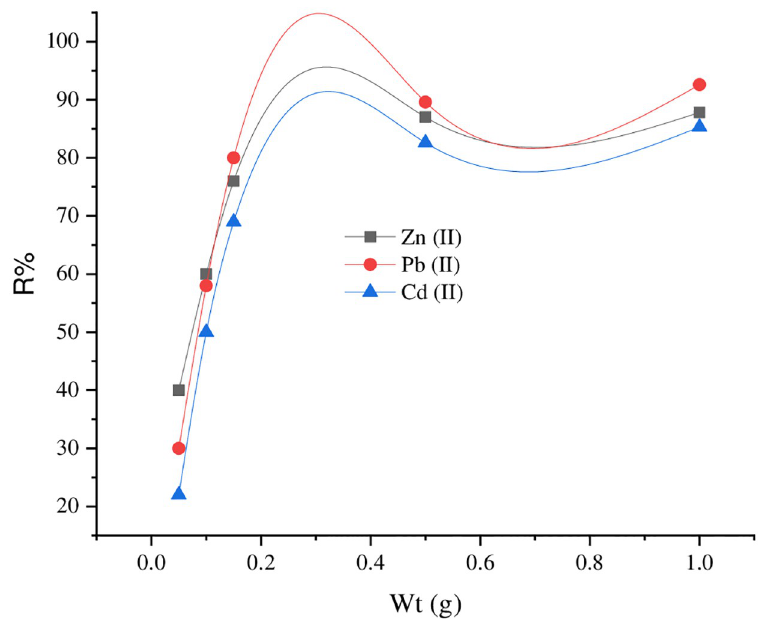
Fig 10. The SnCaAl 2 O 3 nanoparticles dose effect on the adsorptions of Zn +2 , Cd +2 , and Pb +2 , at the constant of volume solution (50 ml) and initial concentration of these ions (500 mg/l).